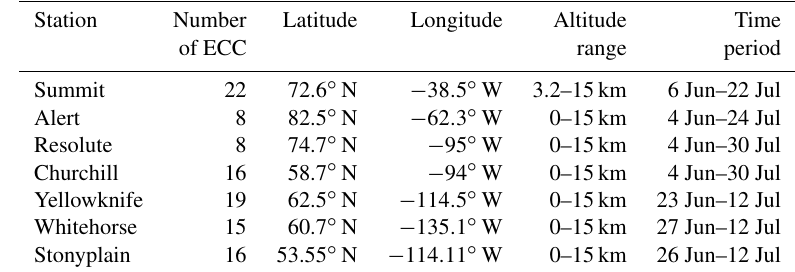
Table 2. Characteristics of the ECC sounding stations used during summer 2008. Station Number Latitude Longitude Altitude Time of ECC range period